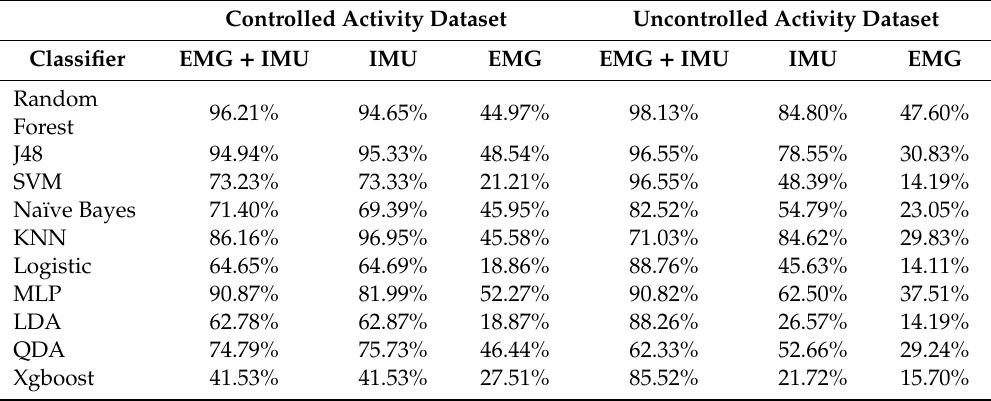
Table 15. Overall classification accuracy for di ff erent sensor combinations for controlled and uncontrolled datasets.